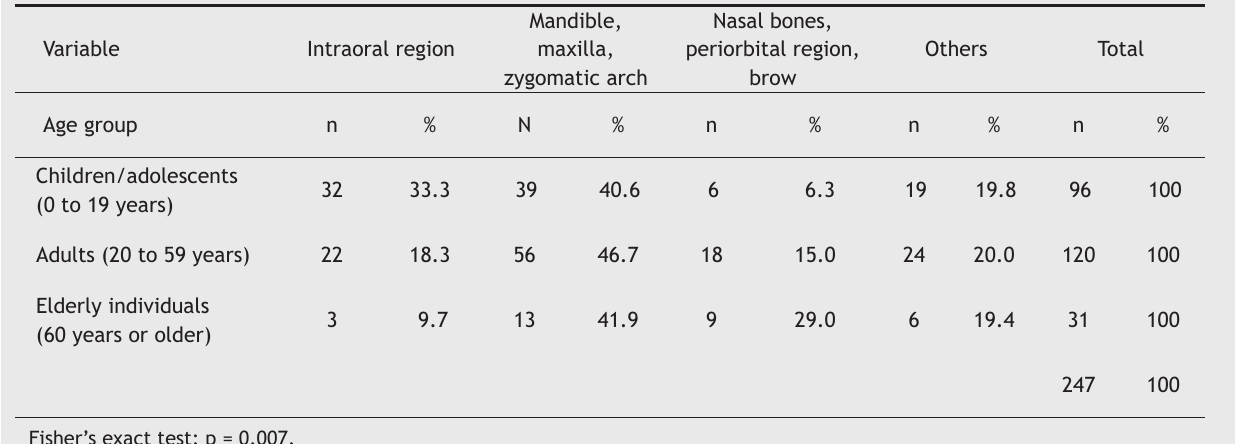
Table 5 Distribution of age groups according to site of injury; Campina Grande, Brazil, 2012 (n = 247).